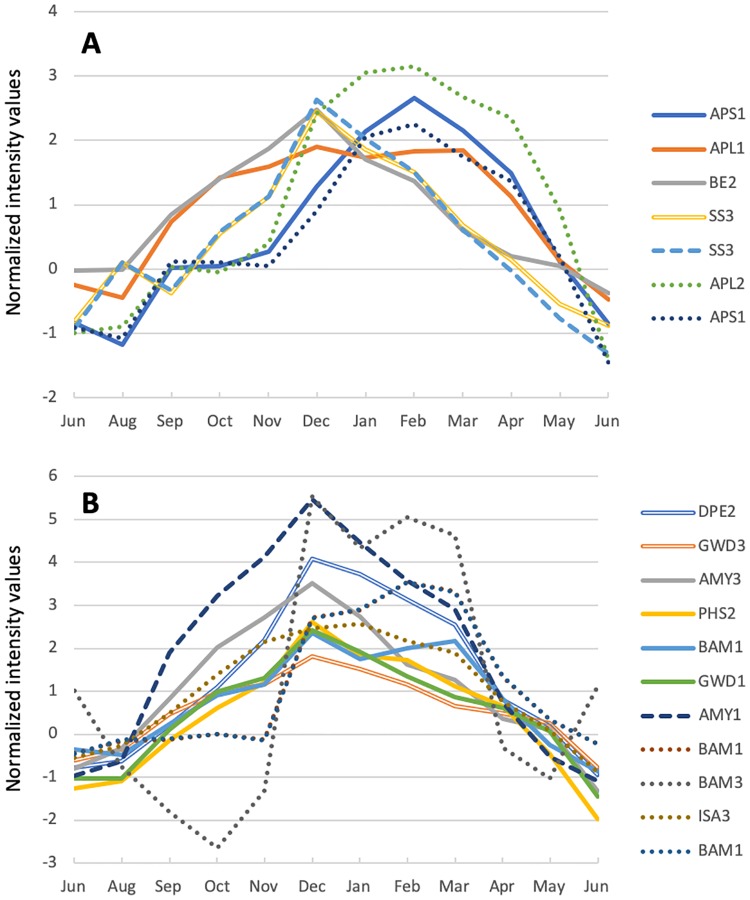
Annual expression patterns of starch-related genes.Each line represents the average normalized intensity value of an individual transcript of a gene involved in starch synthesis (A) or starch degradation (B), as listed in Table 5. Broken lines and solid lines indicate transcripts up-regulated by SD and LT conditions, respectively. Double lines indicate transcripts up-regulated by both SD and LT conditions. Dotted lines indicate transcripts not up-regulated by either SD or LT conditions in this study.